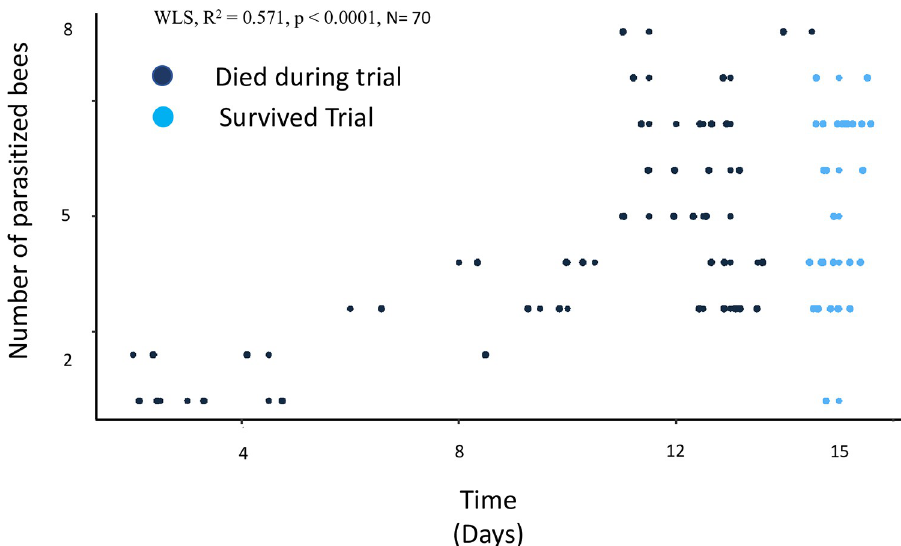
Fig 3. Number of bees parasitized by individual Varroa over time Each point is a Varroa observed over the course of a 15-day trial as it parasitized a small group of bees in the laboratory (8 bees per group, N = 70 replicates). The y-axis represents the number of hosts parasitized by an individual mite, while the x-axis represents how long the mite survived in the trial. Longevity was not a significant factor contributing to the number of parasitized hosts ( p = 0.124, Mann-Whitney U Test, nor was time, which was weakly correlated. (WLS regression, R 2 = 0.571, F (1, 68) = 90.59, p < 0.0001) Individual points have been slightly offset on the x-axis using the jitter function in the ggplot package in R so that points are not hidden by overlapping. All points should be read to the nearest whole number on the y-axis.